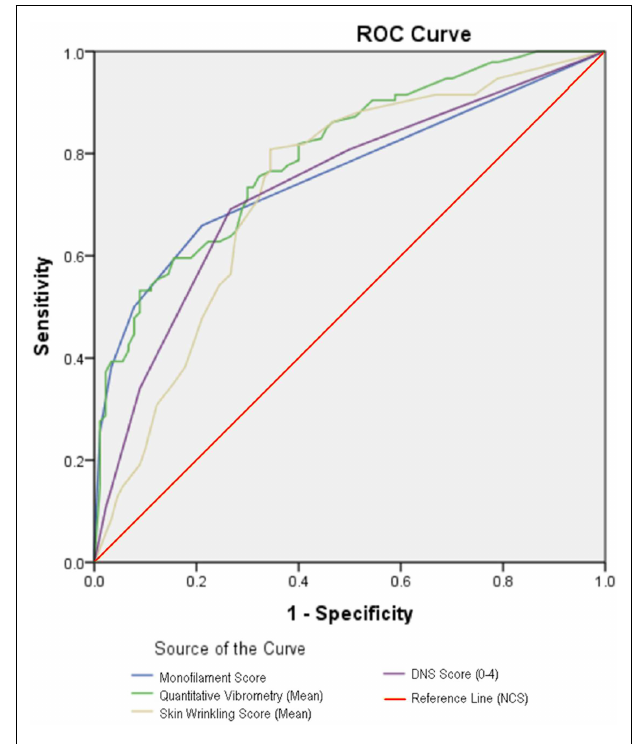
FIGURE 3 | ROC of various test parameters.